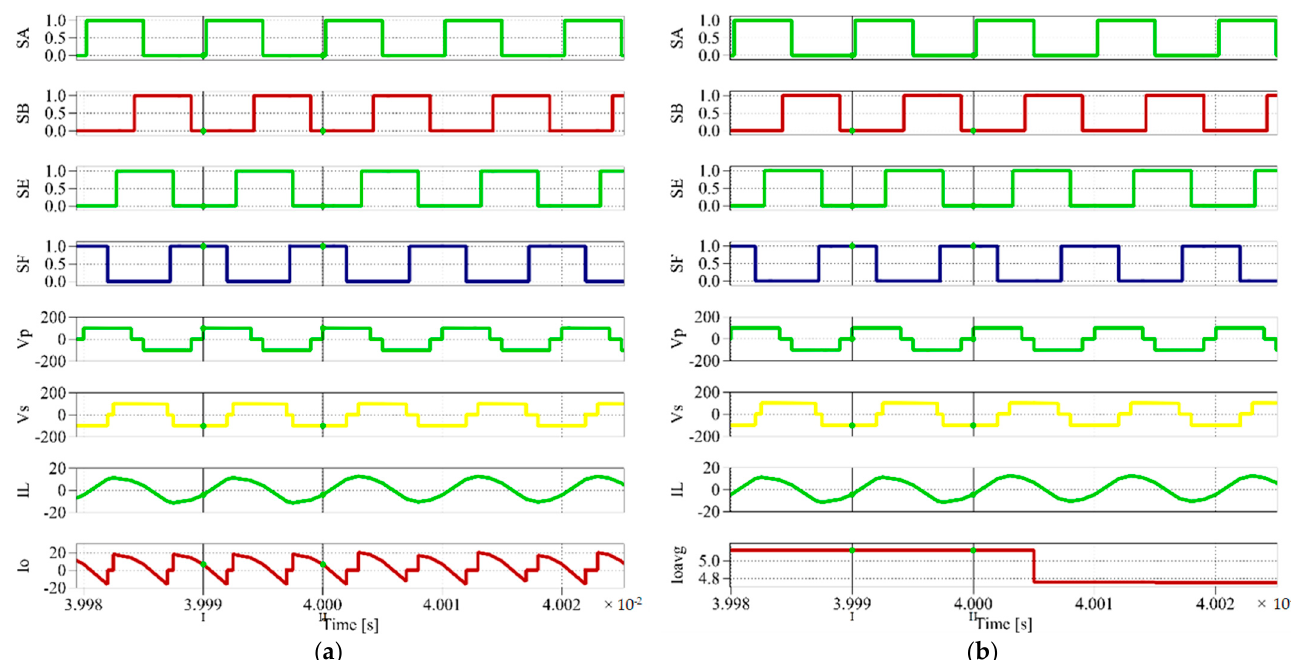
Figure 10. Gate control signals, primary and secondary voltage, inductor current and output current (step change, PLECS simulation): ( a ) Output current; ( b ) Average Output current.